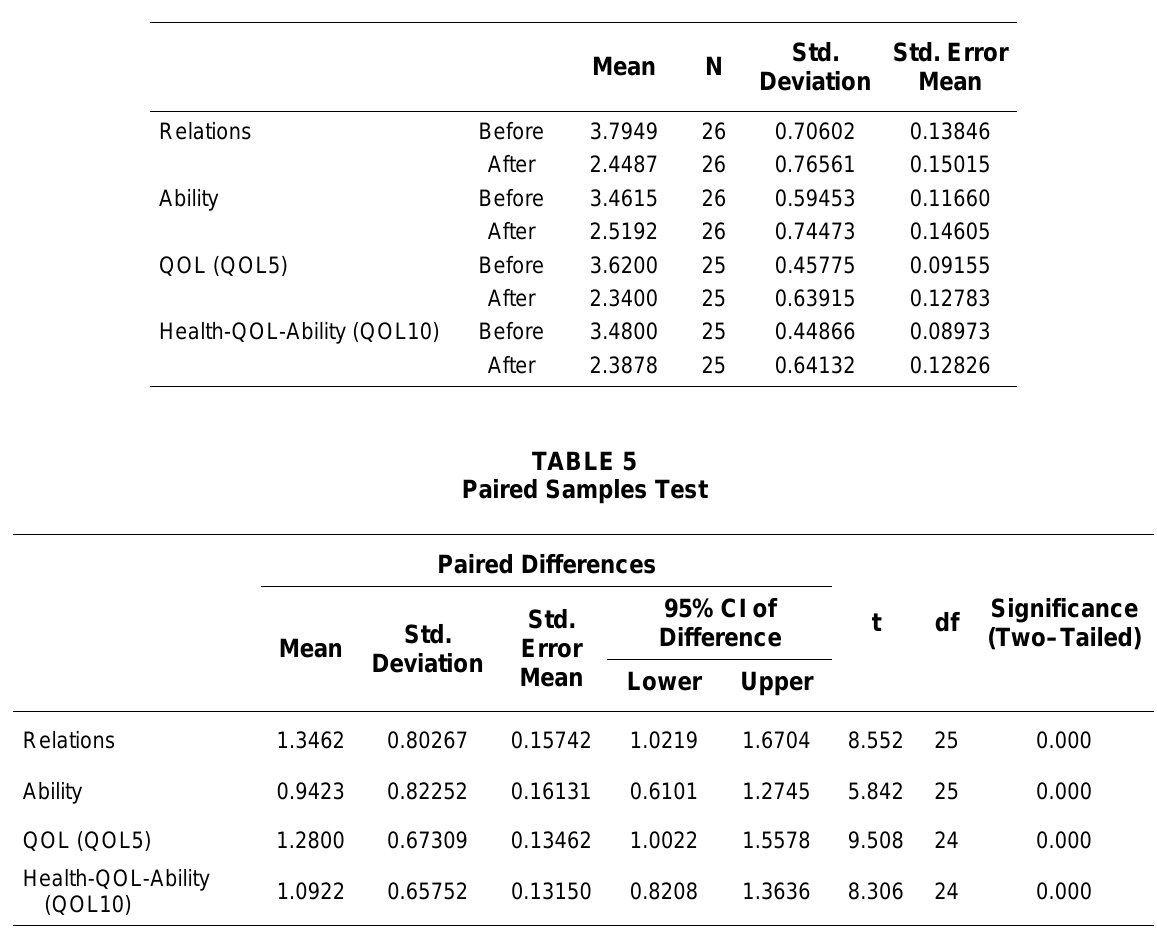
Paired Samples Statistics